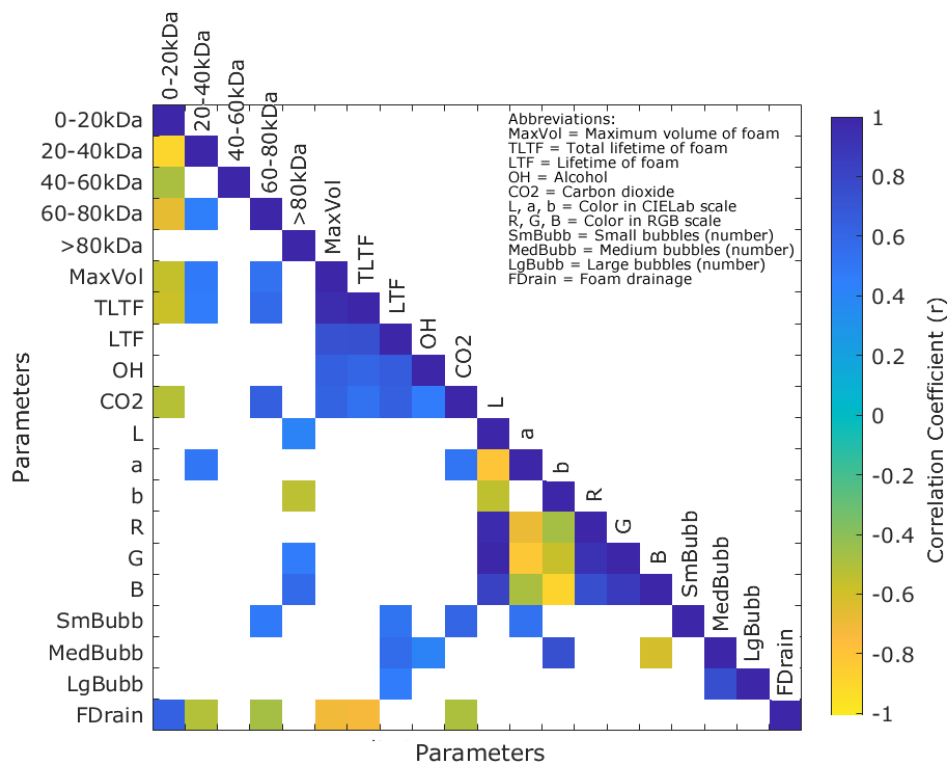
Figure 1. Matrix showing the correlations ( p < 0.05) between the physical parameters (color, foam, and bubbles) and the proteins grouped by molecular weight (0–20 kDa, 20–40 kDa, 40–60 kDa, 60–80 kDa and >80 kDa).